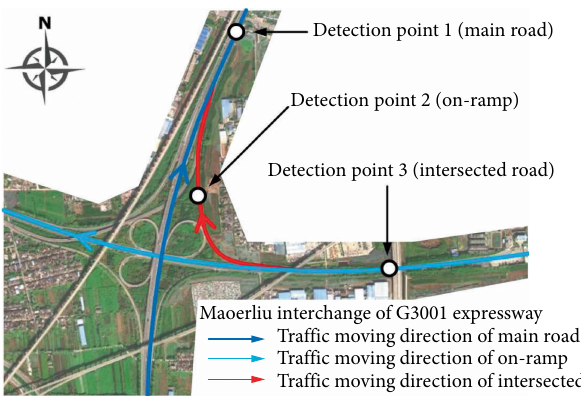
Figure 11: Maoerliu interchange of G3001 and the detectors deployment.